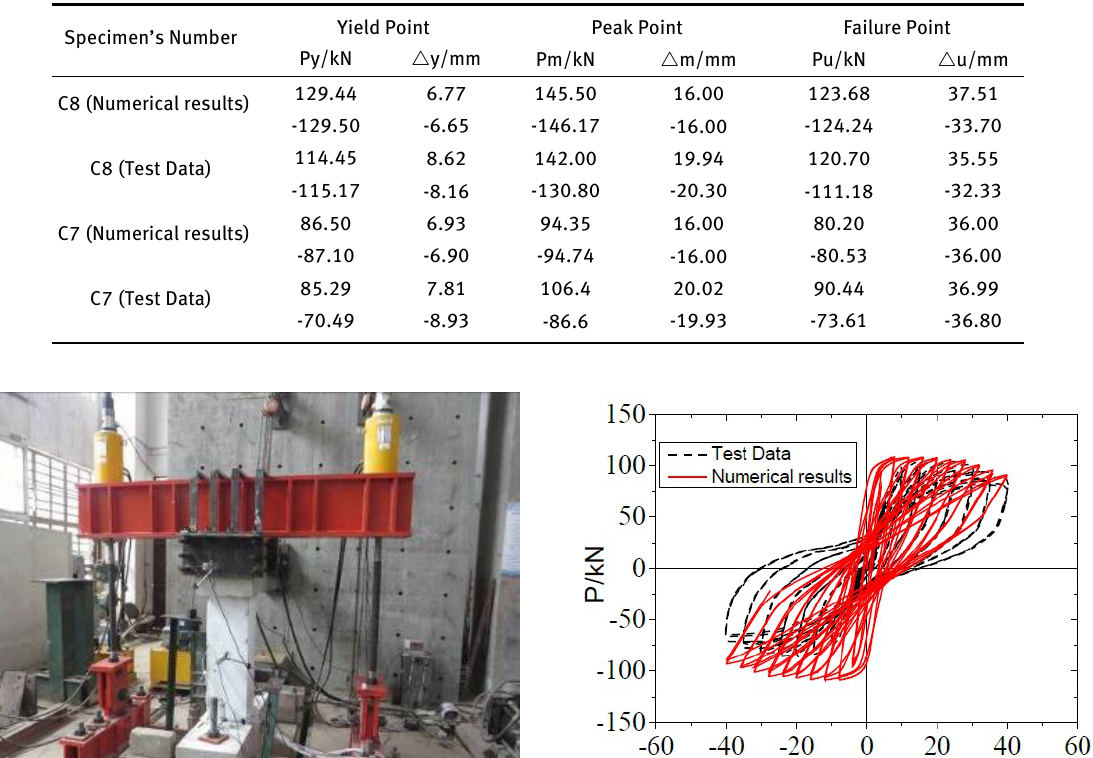
Table 4: Comparison of calculation results and test results data